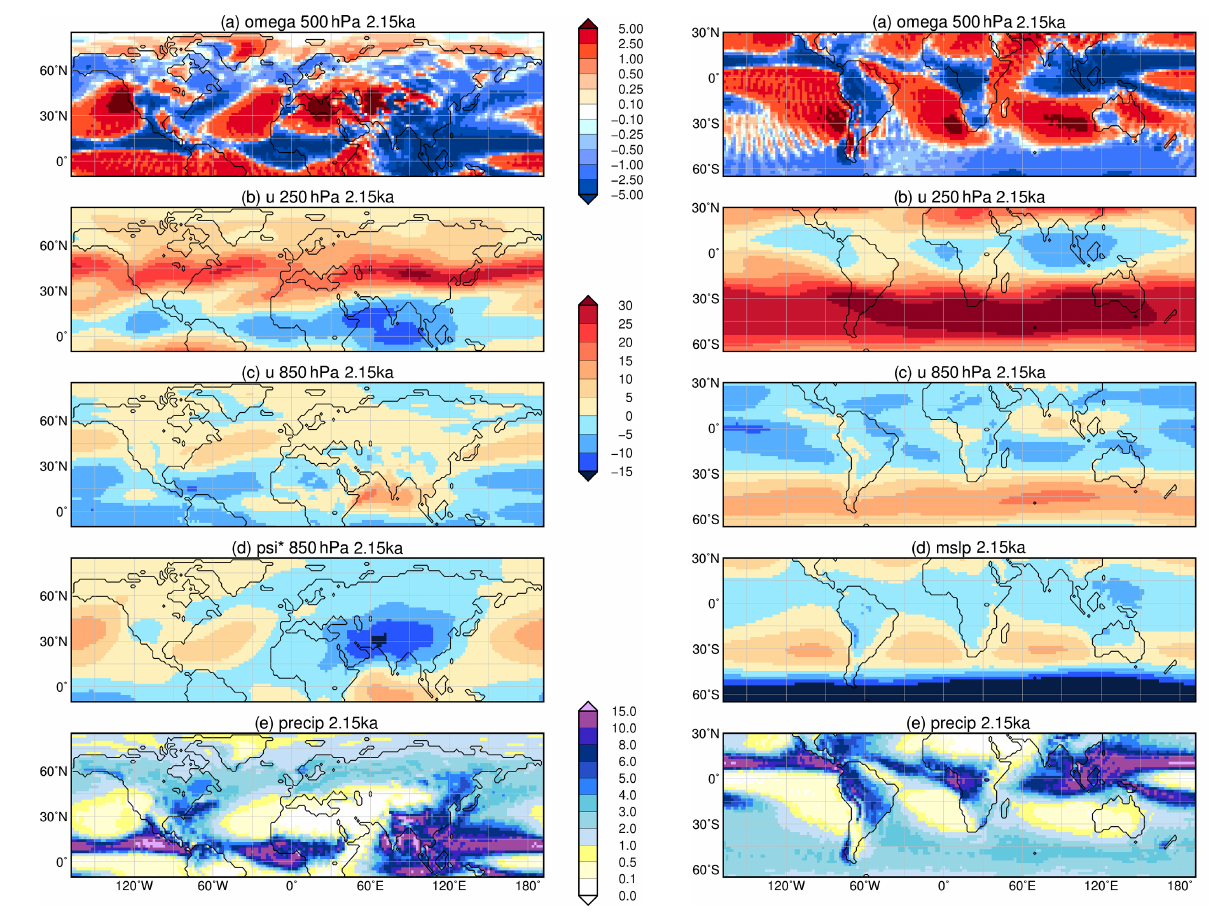
Figure B2. Simulated JJA mean climate at 2.15ka, i.e. (a) vertical velocity (omega) in 500hPa (10 − 2 ms − 1 ) with blue colour show- ing uplift; (b) upper-tropospheric zonal wind ( u ) in 250hPa (ms − 1 ) with blue colours indicating easterly wind; (c) low-level zonal flow ( u ) in 850hPa (ms − 1 ); (d) zonal anomaly in lower-tropospheric streamfunction (psi*, in 10 7 m 2 s − 1 ) reflecting the standing waves, with blue colours indicating cyclonic circulation; and (e) mean sea- sonal precipitation (mmd − 1 ).